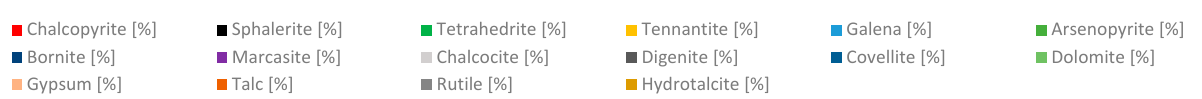
Minerals 2021 , 11 , x